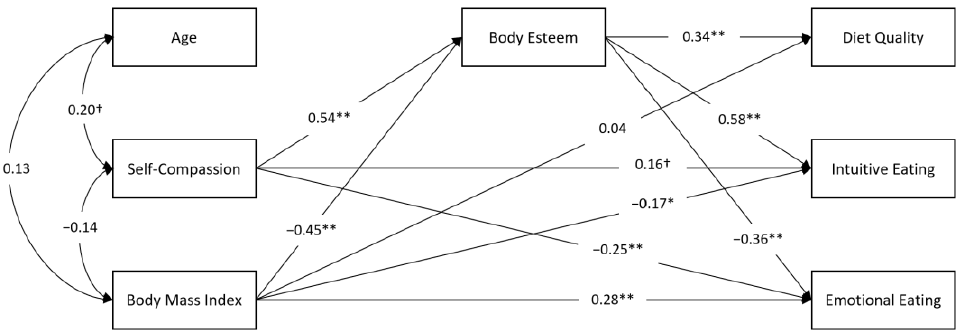
† p < 0.10; * p < 0.05; ** p <